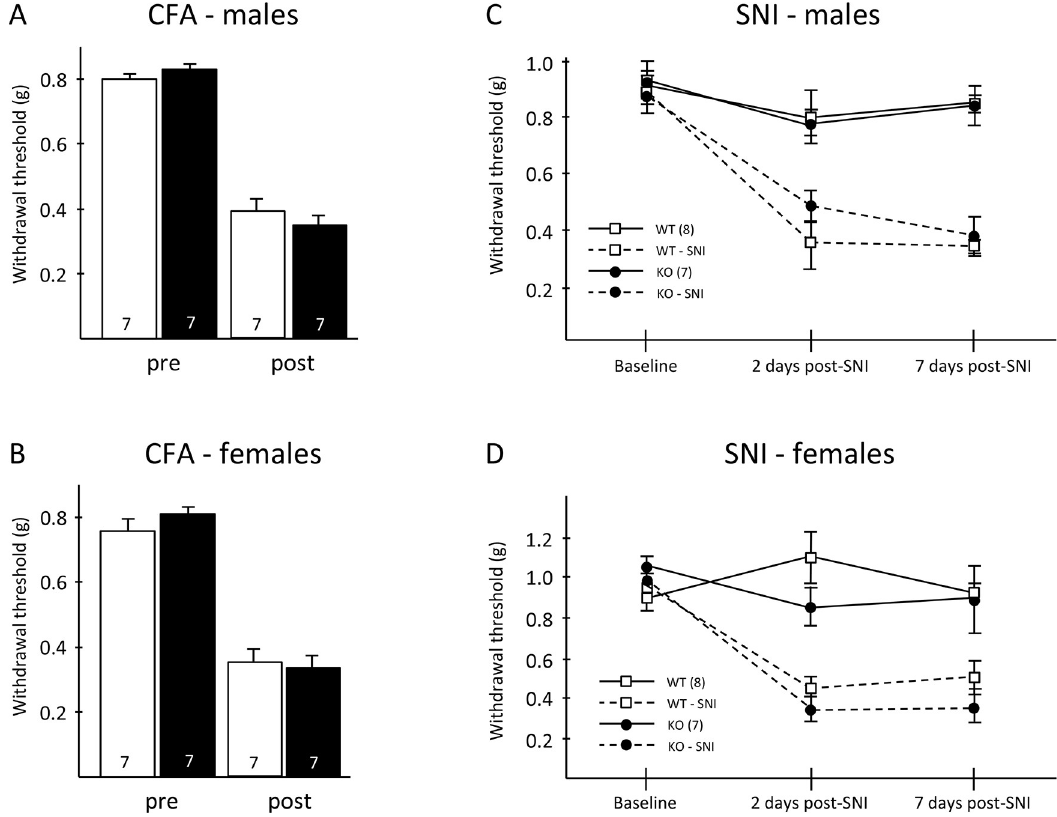
Fig 4. Tissue and nerve injury-induced mechanical hypersensitivity in Hippocalcin-like 4 mutant mice. (A-B) Mechanical allodynia did not differ between Hpcal4 mutant and control mice 3 days after CFA injection. (C-D) Hpcal4 mutant mice also developed normal mechanical allodynia 2 and 7 days after spared nerve injury (SNI). Data are presented as mean ± SEM. Statistical significance was determined by Student’s t-test in A and B and by Two-way repeated measures ANOVA in C and D.